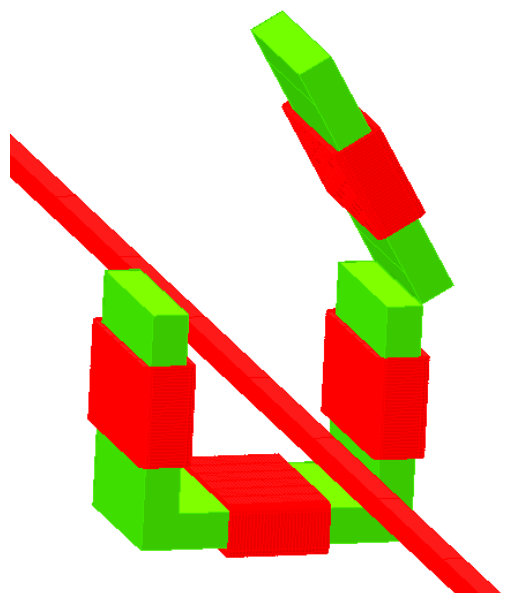
Figure 2. 3D geometrical model 3 of a split-core current transformer while mounted in a switchboard without disconnecting the bars.